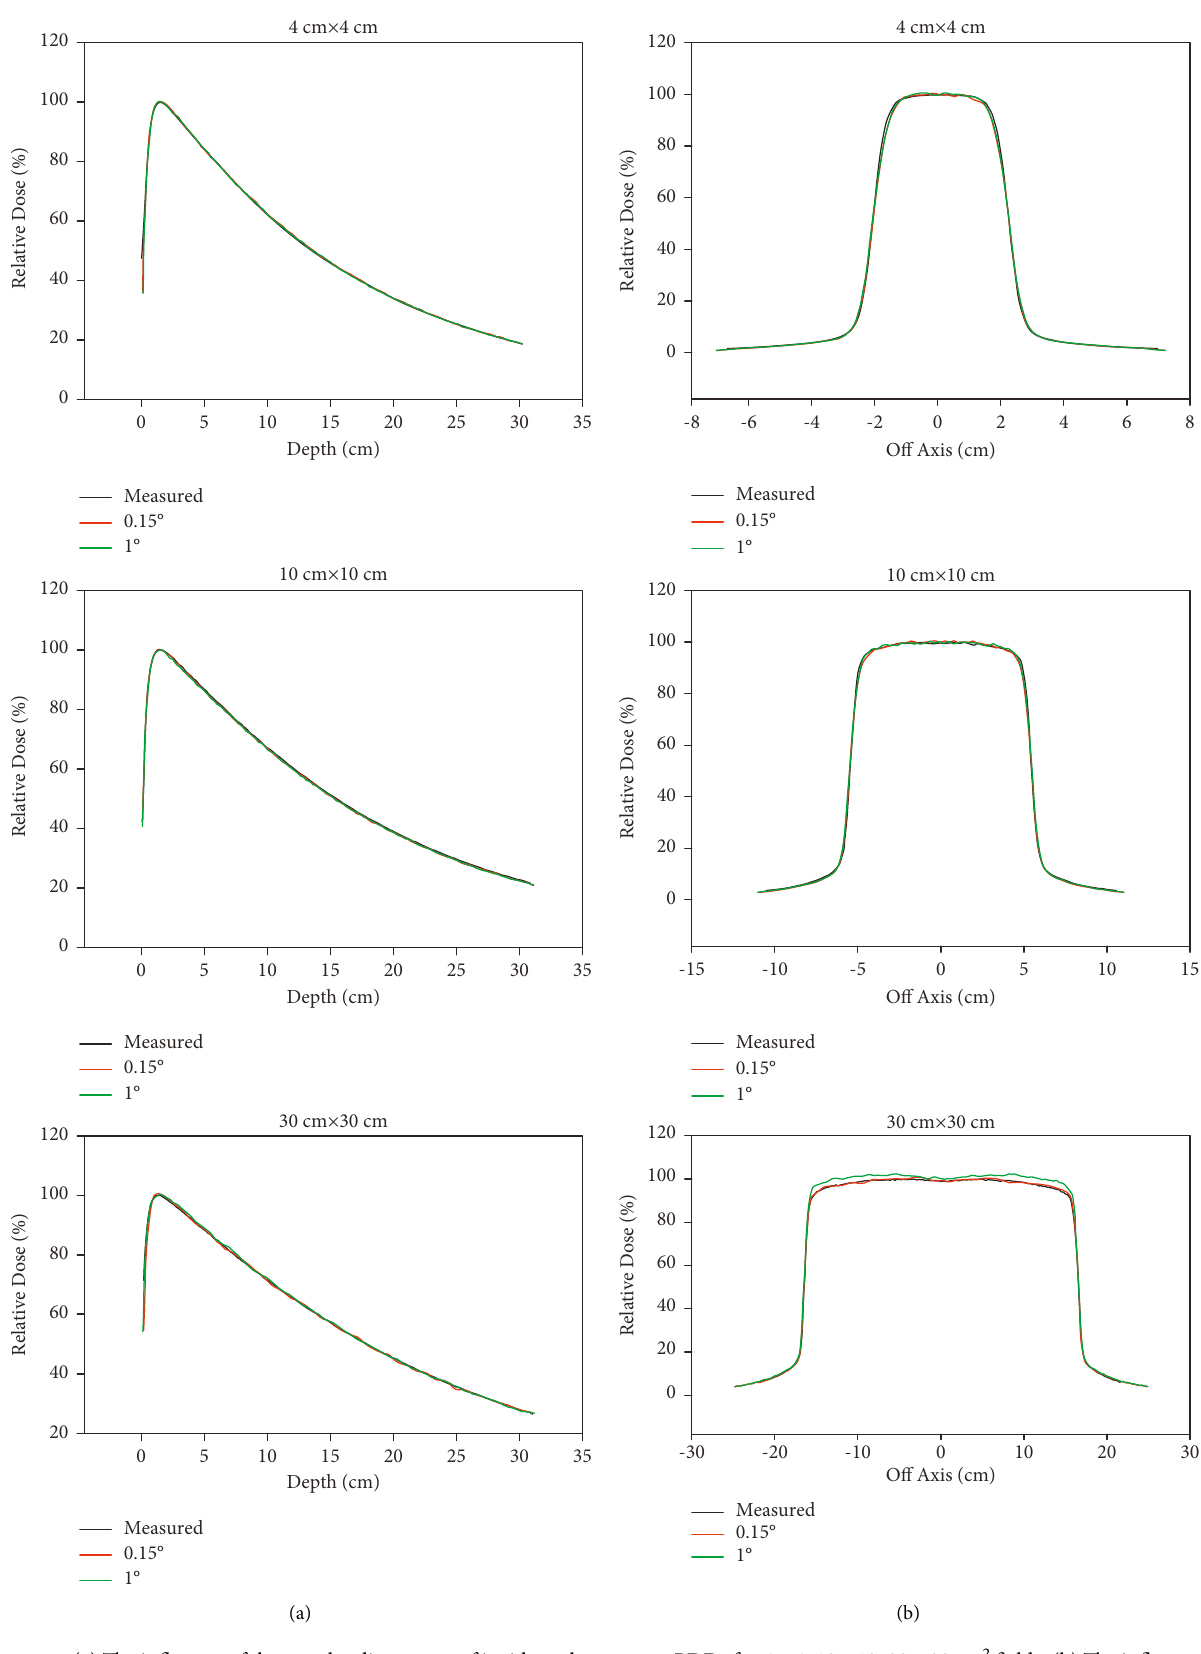
Figure 5: (a) The influence of the angular divergency of incident electrons on PDDs for 4 × 4, 10 × 10, 30 × 30cm 2 fields. (b) The influence of angular divergency of incident electron on OARs for 4 × 4, 10 × 10, 30 × 30cm 2 fields at 10cm depth. The red curve represents the dose curve when the angular divergency is 0.15 ° , the green curve represents the dose curve when the angular divergency is 1 ° , and the black curve represents the measured dose